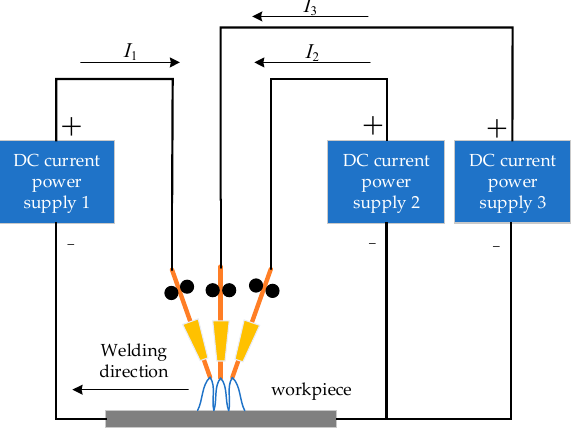
Figure 2. High-speed triple-wire gas metal arc welding process.